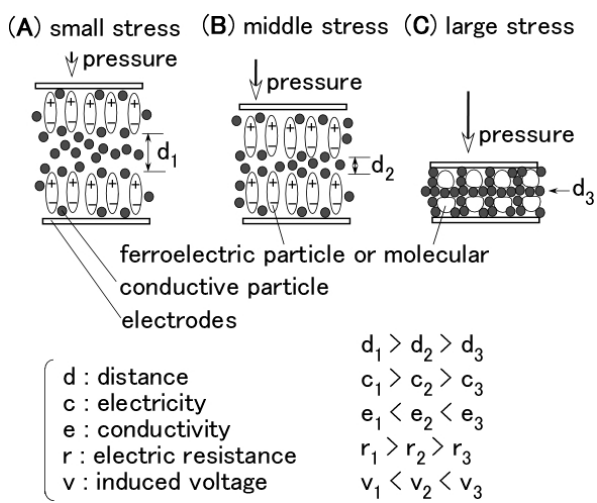
Figure 7. Schematic diagram of the physical model of Piezo effect of MCF rubber.